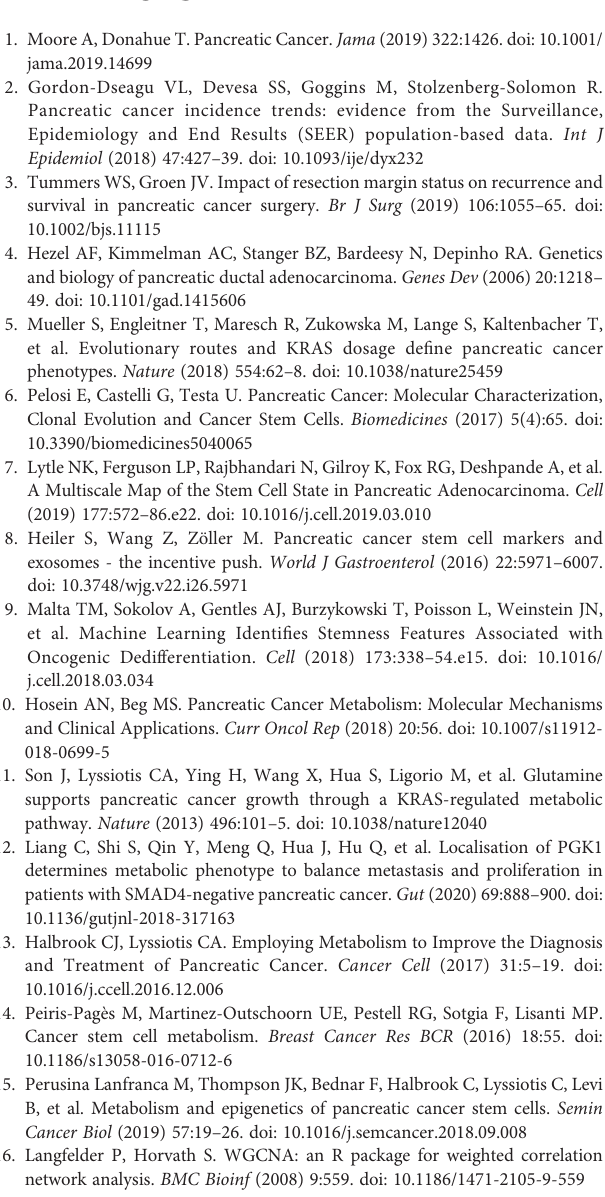
Supplementary Figure 2 | Summary of mutation information from patients with high and low mRNAsi values. Supplementary Figure 3 | Differences in immune microenvironment between samples with high and low mRNAsi values. Supplementary Figure 4 | The process of WGCNA. (A) RNA-seq data were fi ltered to exclude outliers. (B) The corresponding associations among PDAC samples, their mRNAsi and metabolic activities were determined. (C, D) Average linkage hierarchical clustering was further conducted based on TOM-based dissimilarity measurements. (E) To reduce the number of gene modules, dynamic tree cuts with high similarities were merged based on a cutoff height of 0.25. Supplementary Figure 5 | The expression of target genes in fi broblasts derived from pancreatic